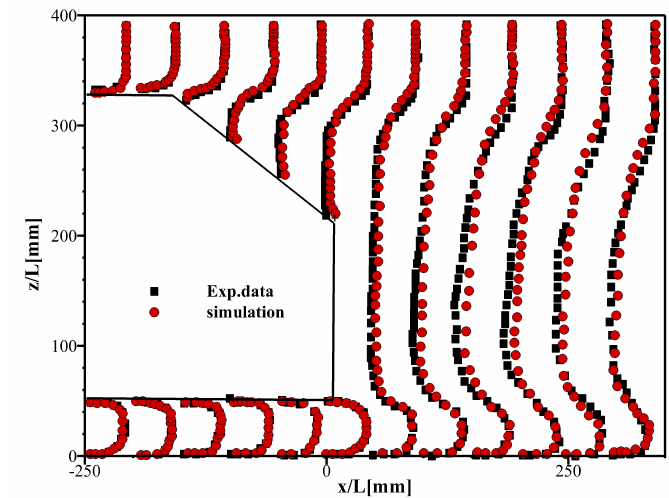
Figure 9. Profiles of the streetwise velocity component in the wake region of 35 ◦ slant angle of the Ahmed